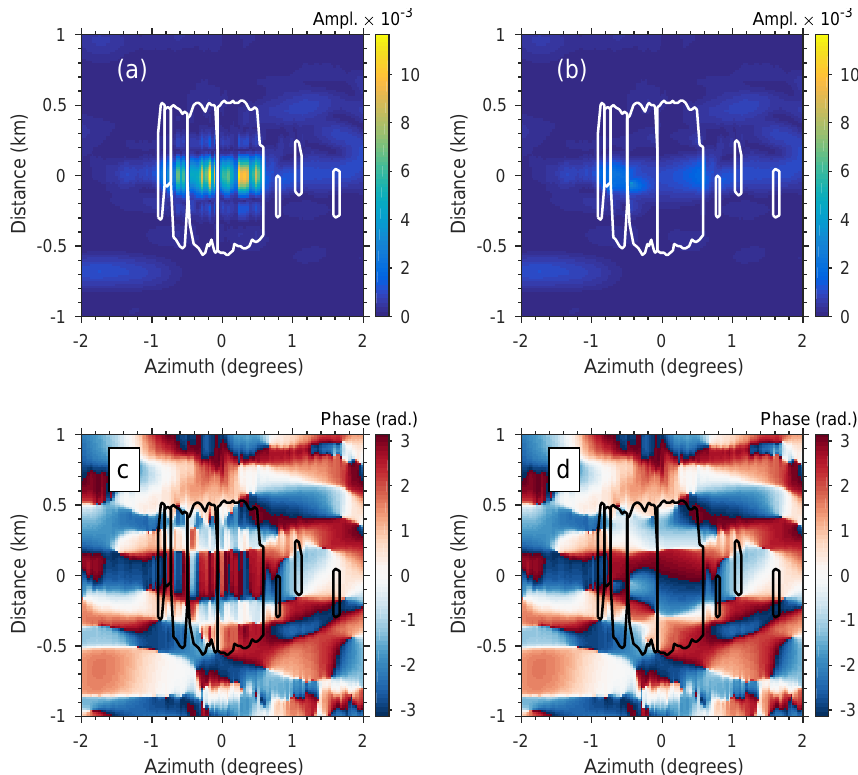
Figure 9. Identifying and filtering the impact of a wind turbine on weather radar I/Q data recorded on 8 September 2016 at 07:00UTC. Panel (a) shows the amplitude of the recorded I/Q data near the wind turbine. Data found to match the point target signature are enclosed by white lines. Panel (b) shows the amplitude of the filtered I/Q data. Panel (c) shows the phase of the recorded I/Q data, with the wind-turbine- impacted areas encircled in black. Panel (d) shows the phase of the filtered